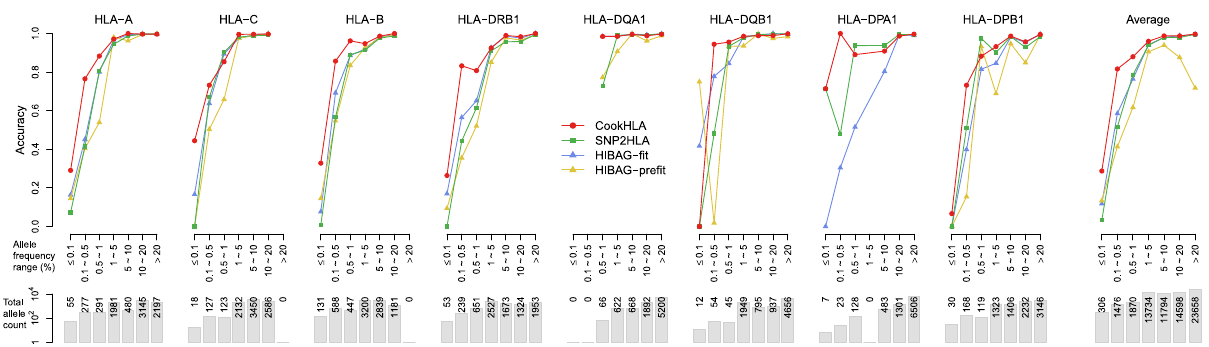
Fig. 4 Imputation accuracy in each allele frequency bin. We used cross-validation by splitting the T1DGC panel into reference ( N = 1000) and the target sample ( N = 4225). For HIBAG-pre fi t, we used the European pre fi t model. The accuracy refers to sensitivity to correctly impute an allele given a speci fi c